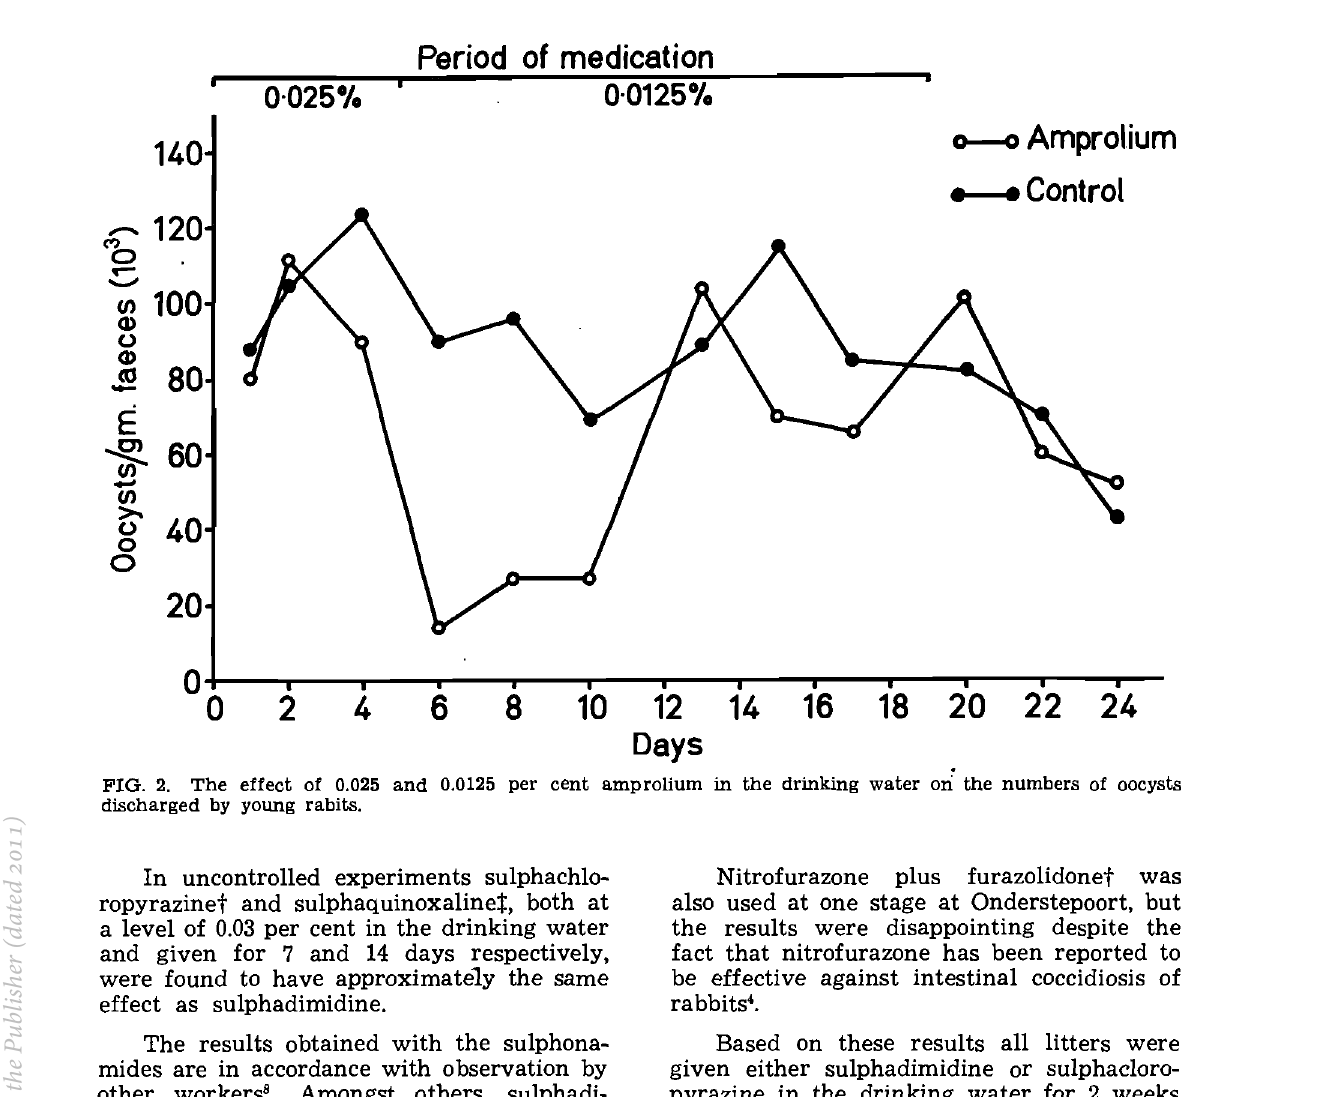
In uncontrolled experiments sulphachlo ropyrazinet and sulphaquinoxalinet, both at a level of 0.03 per cent in the drinking water and given for 7 and 14 days respectively, were found to have approximate1y the same effect as